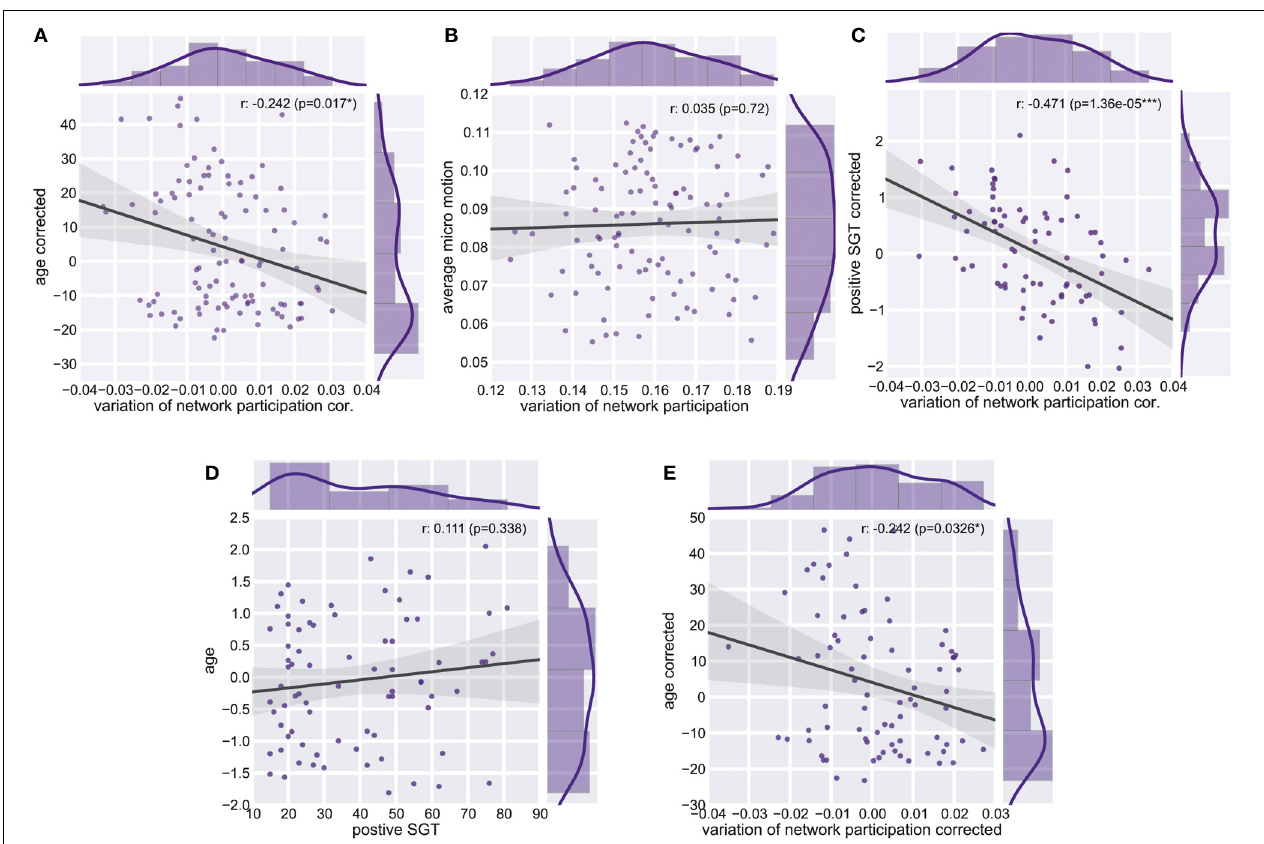
FIGURE 6 | Whole Brain Variation of Participation. (A) Partial correlation between average variation of participation and age corrected for micro-movements. (B) Correlation between average variation and average micro-motion. (C) Partial correlation between average variation of participation and positive self-generated thoughts (SGT) corrected for